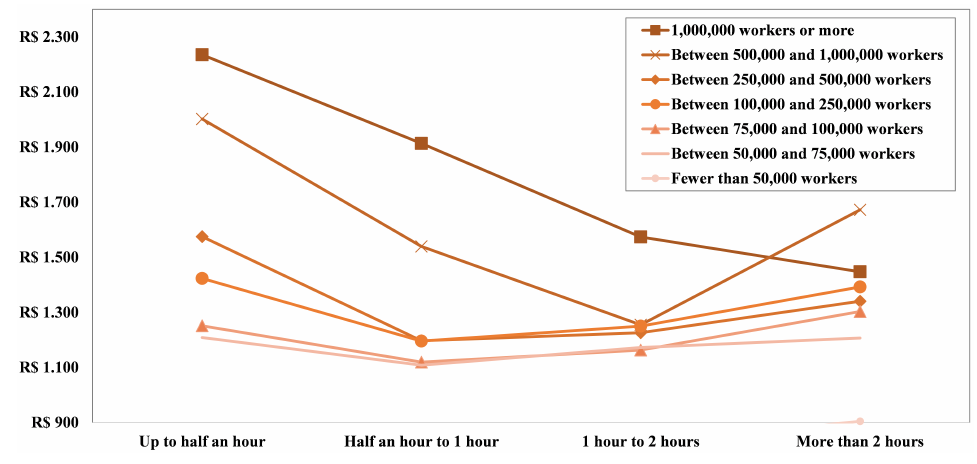
Figure 1: Average wage of workers according to their commuting time from home to work and the size of the municipality of residence, 2010